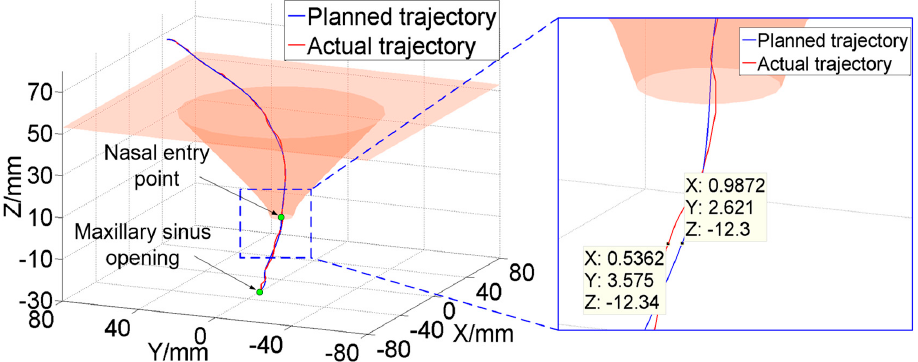
Figure 16. The endoscope tip trajectory and the preoperative planned trajectory.